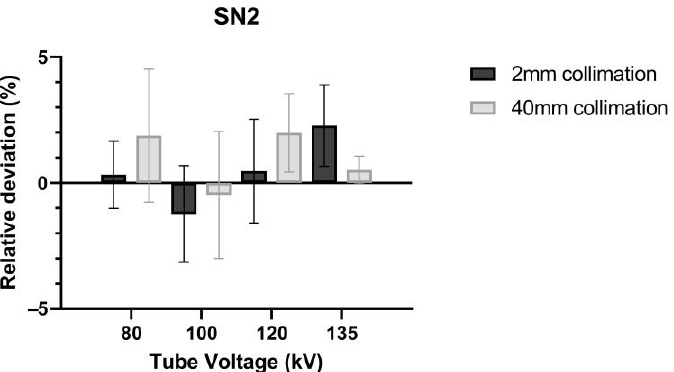
Figure 9. Relative deviation [∆𝐶𝑇𝐷𝐼] 𝑟𝑒𝑓𝐼𝑉𝐼𝑠𝑐𝑎𝑛 calculated for SN2 Head CT protocols over the thinnest beam (2 mm beam width) and the most used in clinic (40 mm beam width) for the entire CT energy range. The standard deviations are represented as error bars.